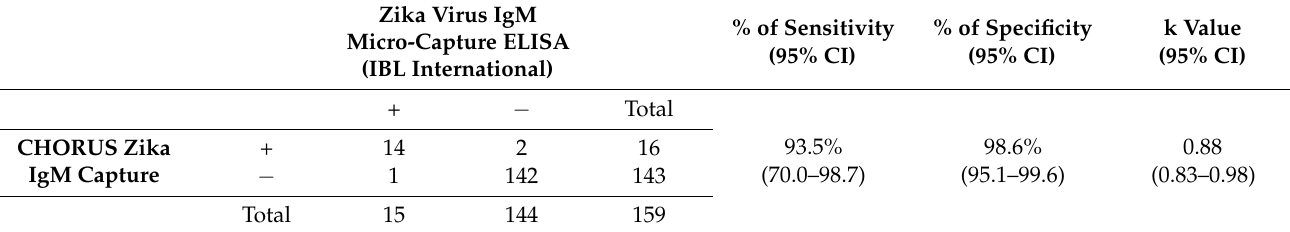
Table 4. Comparison between the CHORUS and IBL IgM capture assays.